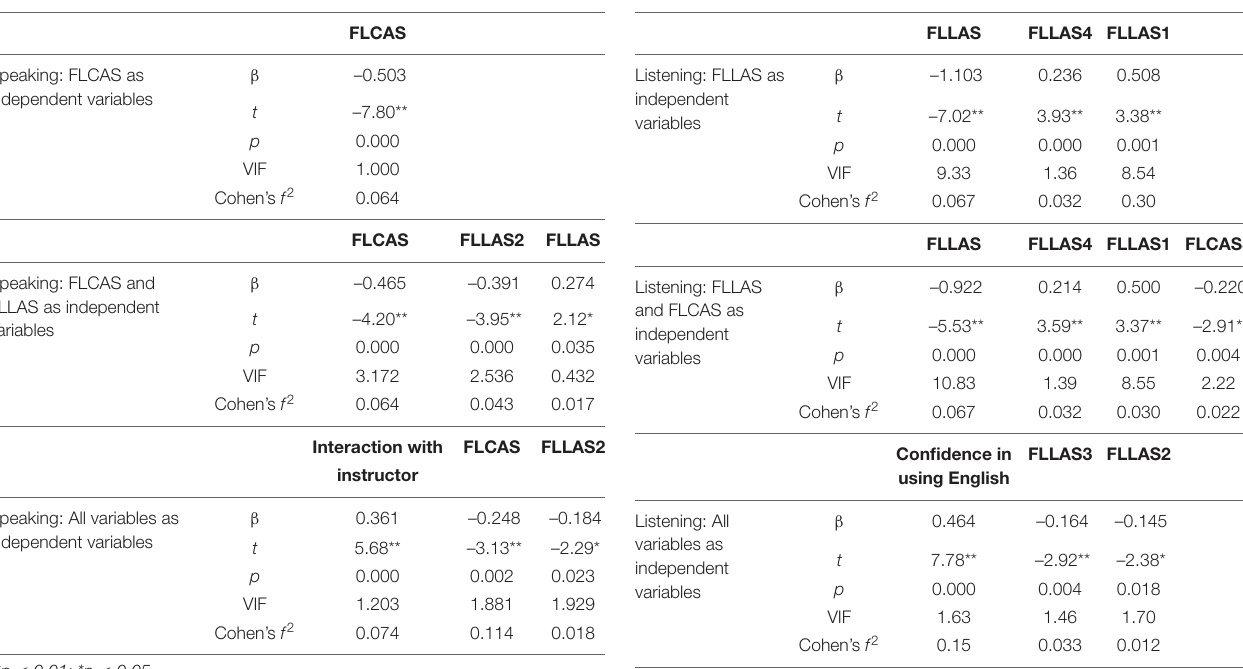
TABLE 5 | Multiple regression coefficients and significance of predictors for speaking English proficiency (phase 2).